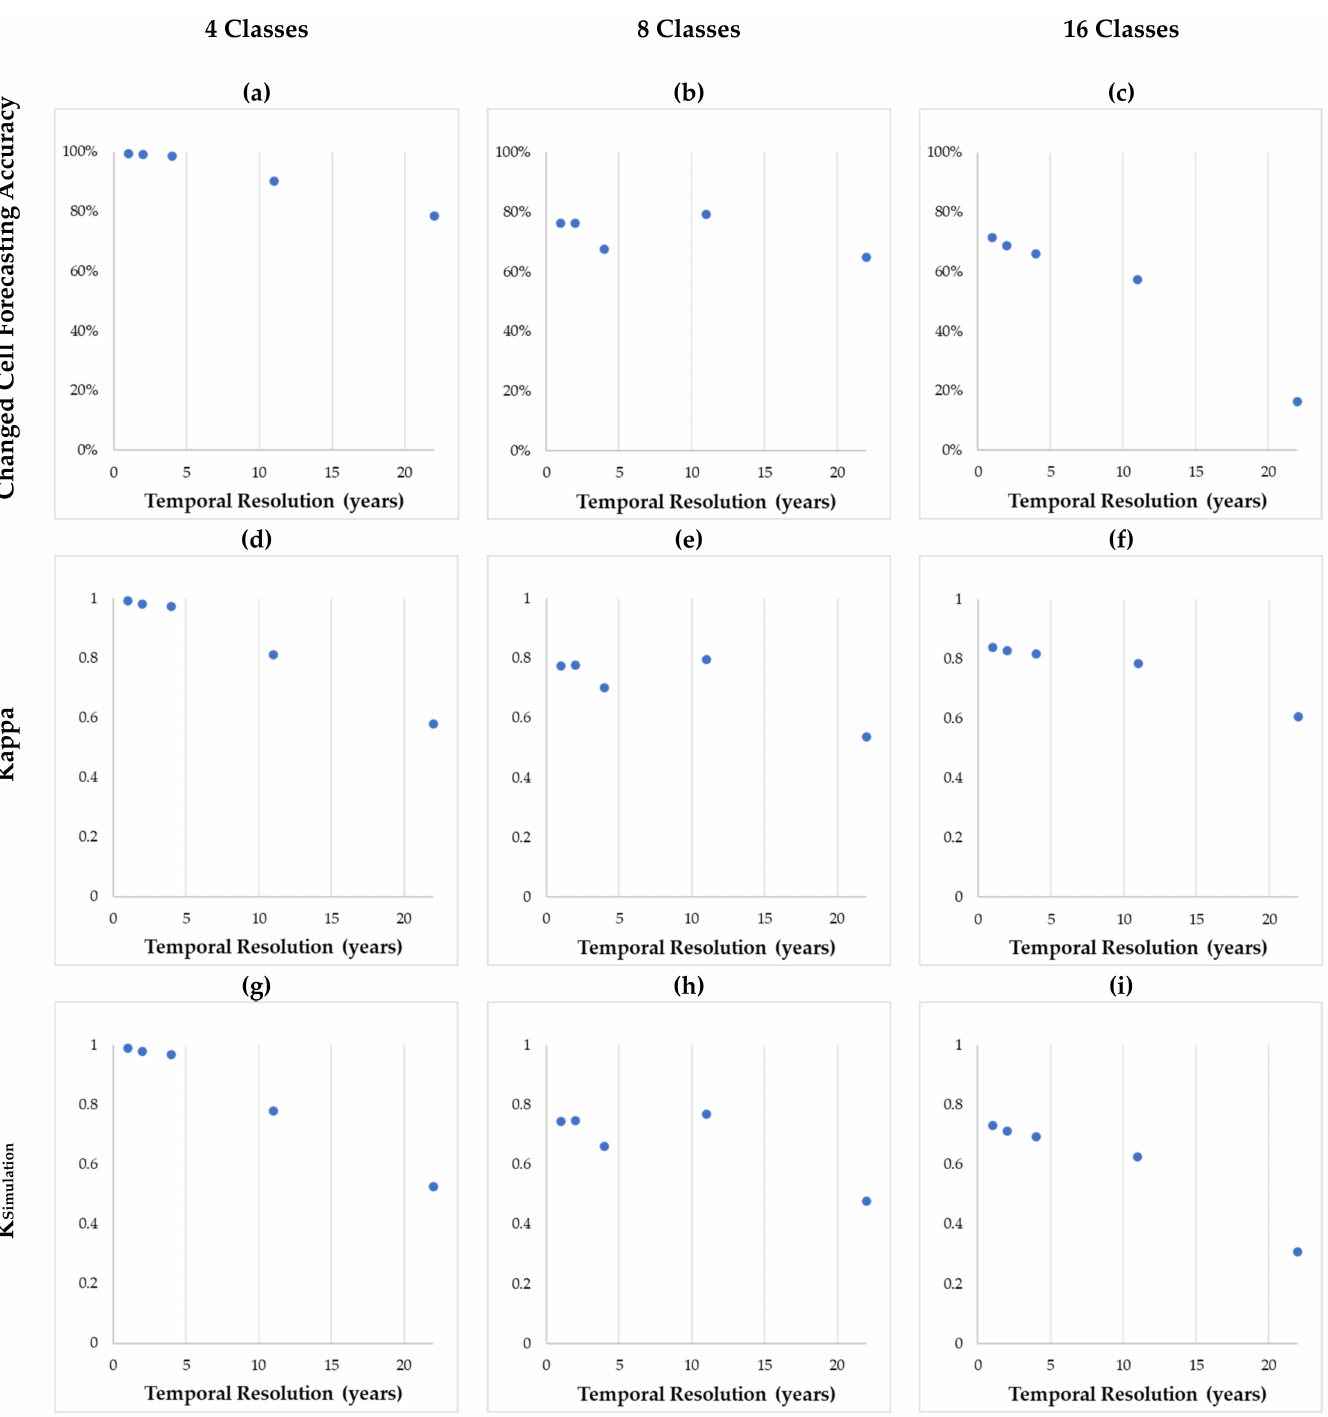
Figure 5. Trends in performance metrics versus increasing temporal resolution in results obtained with the 45-year hypothetical LC datasets with 4, 8, and 16 classes. The changed cell forecasting accuracy ( a – c ), Kappa ( d – f ), and K Simulation ( g – i ) measures have been depicted for each number of LC